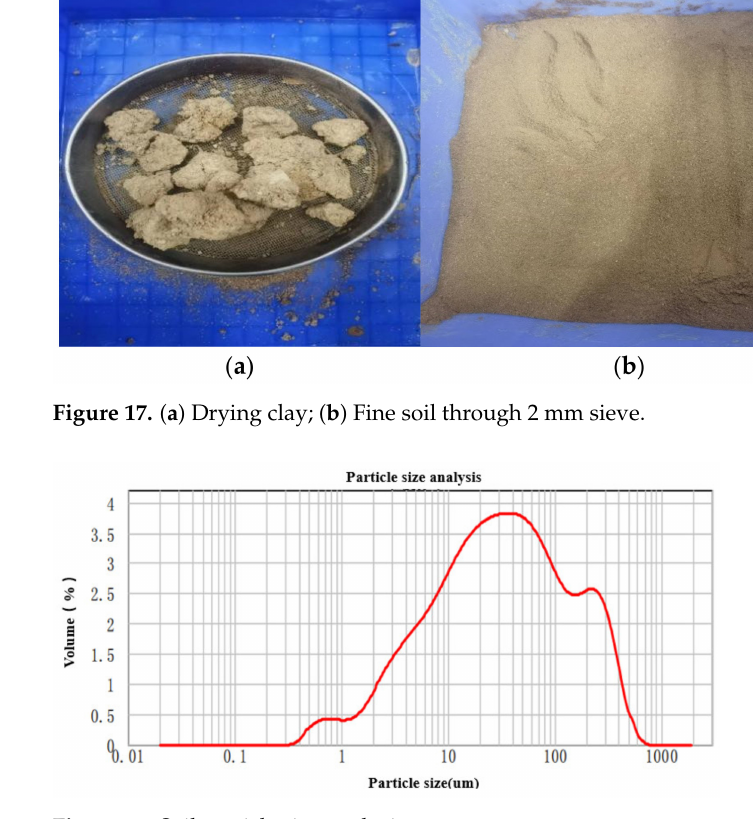
Figure 18. Soil particle size